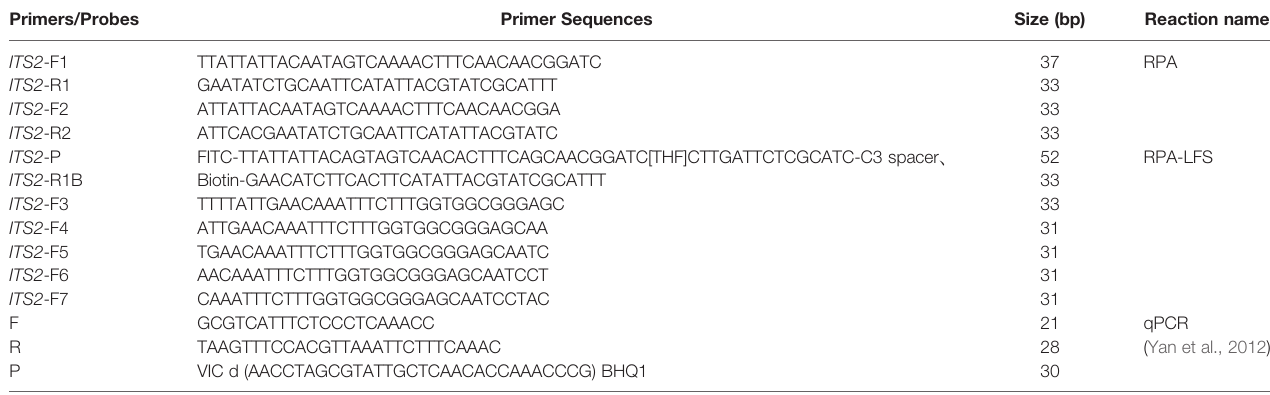
TABLE 1 | Primers and probes for C. tropicalis